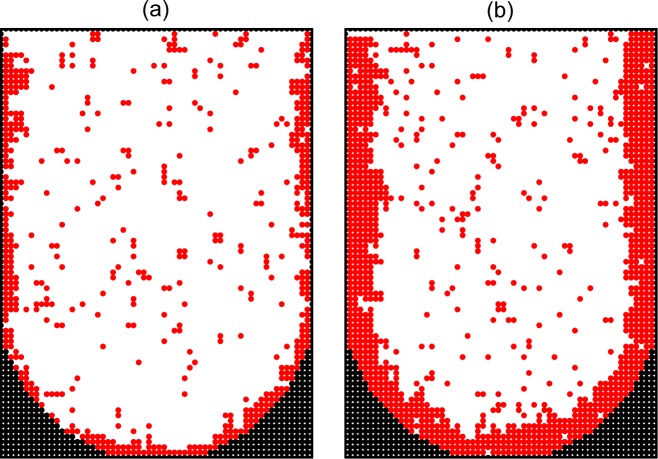
Monte Carlo simulation of cell proliferation and spheroid formation in the microwells.Cross sections of a microwell along the main axis at ϑ = 0.2 (a) and 0.4 (b) in the presence of adhesion (ϵcs = –1.2) of cells to the bottom and side area of the microwell. The adhesion to the top boundary is neglected because in reality the corresponding plane crosses the solution. The diffusion of cells is relatively rapid (pdiv = 10−4). The well and cells are represented by black and red circles, respectively.